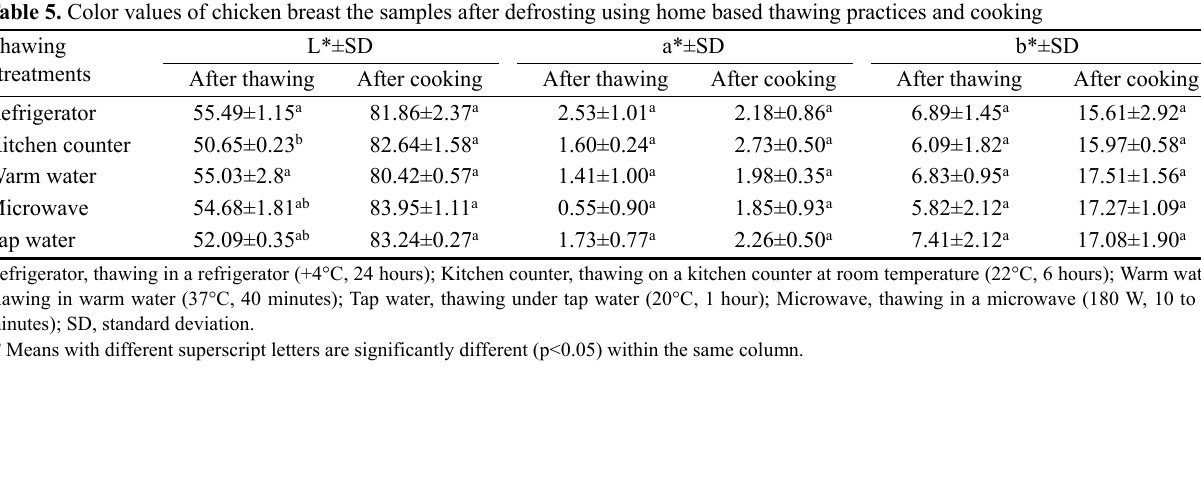
Q8, question 8; N, number of the choices.